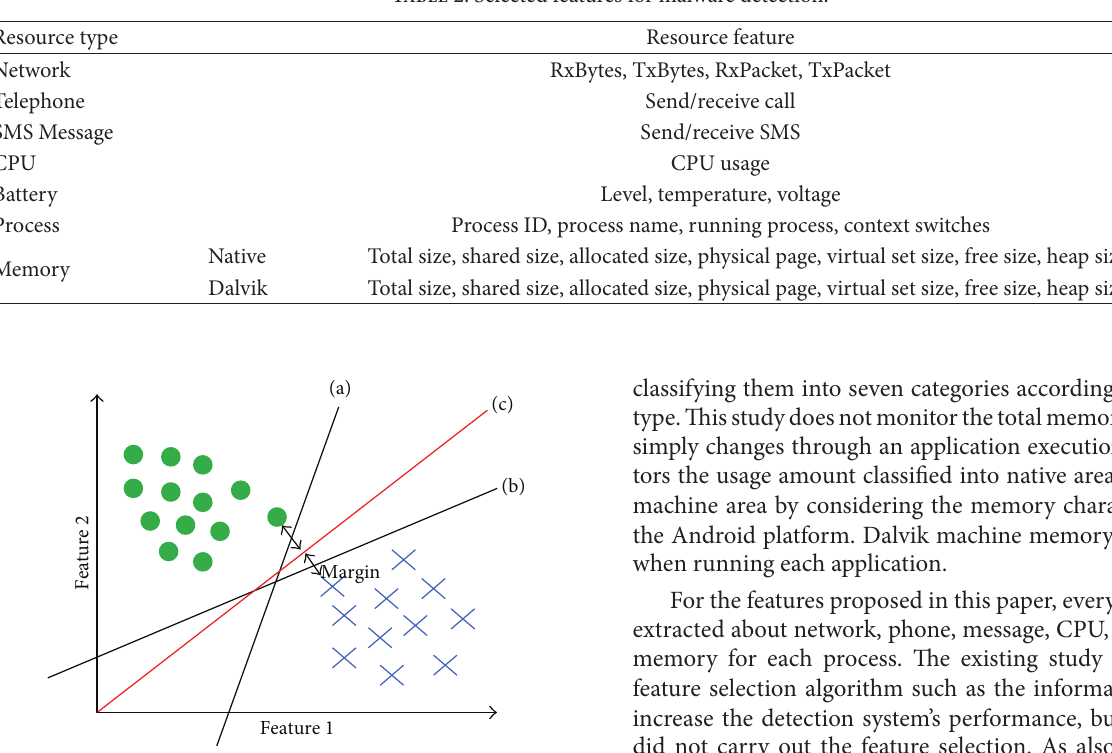
Table 2: Selected features for malware detection.